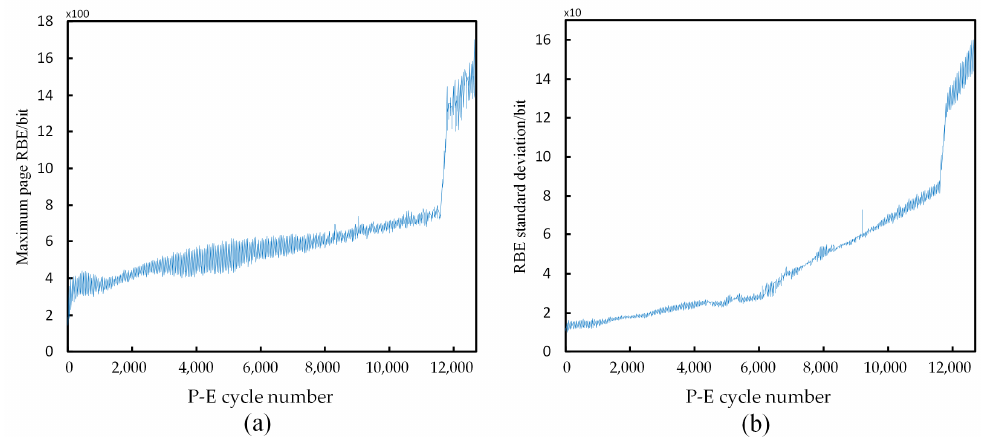
Figure 3. ( a ) The relationship between the maximum RBE numbers of flash memory page and P-E cycle number; ( b ) The relationship between page standard deviation and P-E cycle number.